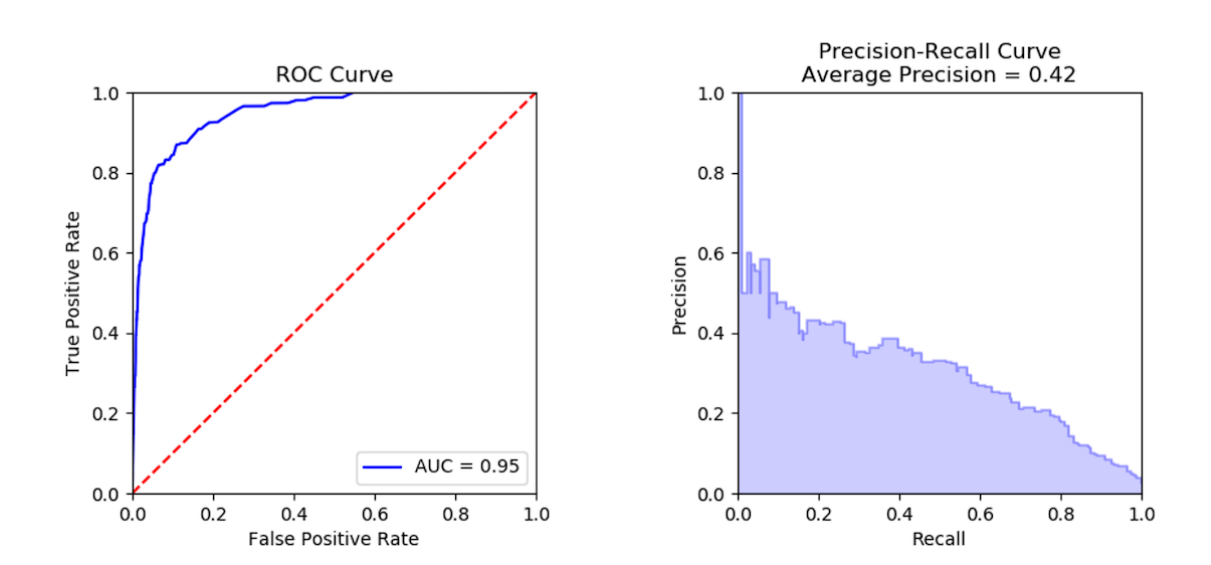
Figure 4. Results on all Supernanny data. AUC: area under the curve; ROC: receiver operating